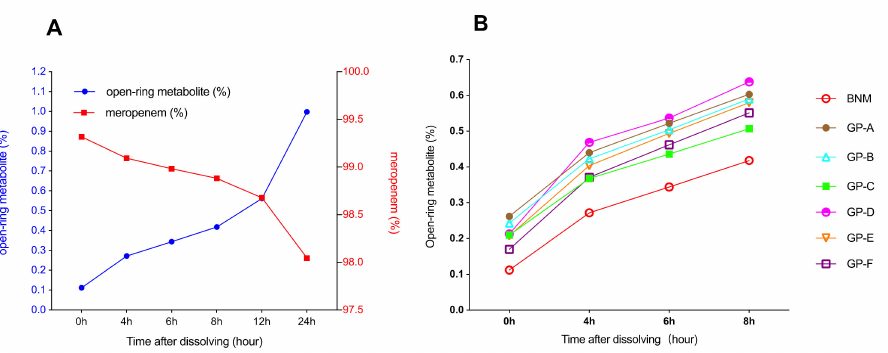
Figure 5. Comparisons of meropenem solution stabilities between BNM and GPs over time. ( A ) Changes in percentages of open-ring metabolites and remaining meropenem within the BNM so- lution over time. ( B ) Changes in open-ring metabolite concentrations within BNM and GPs solutions over time. Each line represents the average of three batches for each